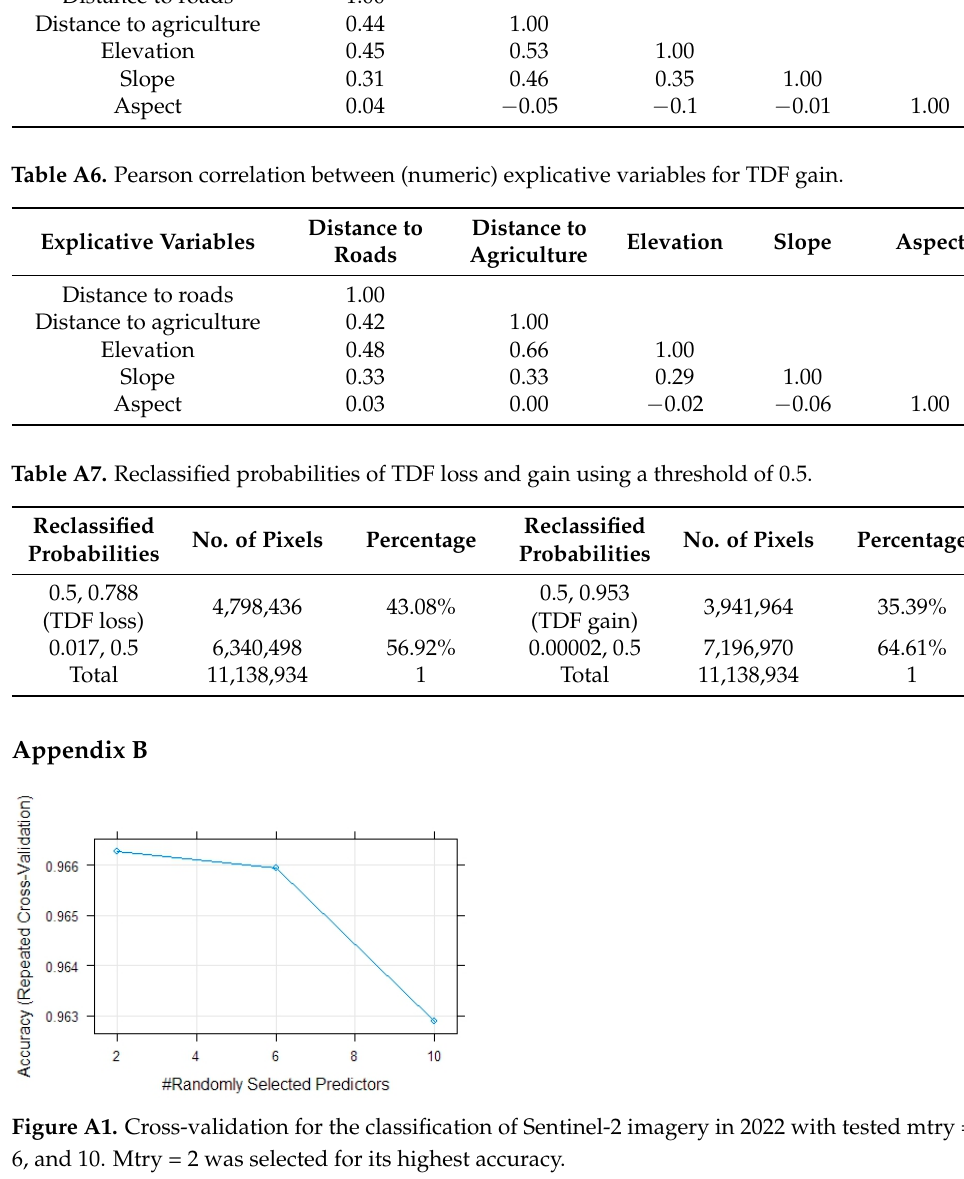
Figure A2. Cross-validation for the classification of Sentinel-2 imagery in 2019 with tested mtry = 2, 6, and 10. Mtry = 6 was selected for its highest accuracy. Figure A3. Land cover classification using ANN for 2019. Irrigated crops is short for Irrigated agri- culture with crops; Irrigated dry is short for Irrigated agriculture without crops (dry); Irrigated wet is short for Irrigated agriculture without crops (wet); Temporal agriculture is short for Temporal agriculture with pasture; Oak is short for Oak forest.